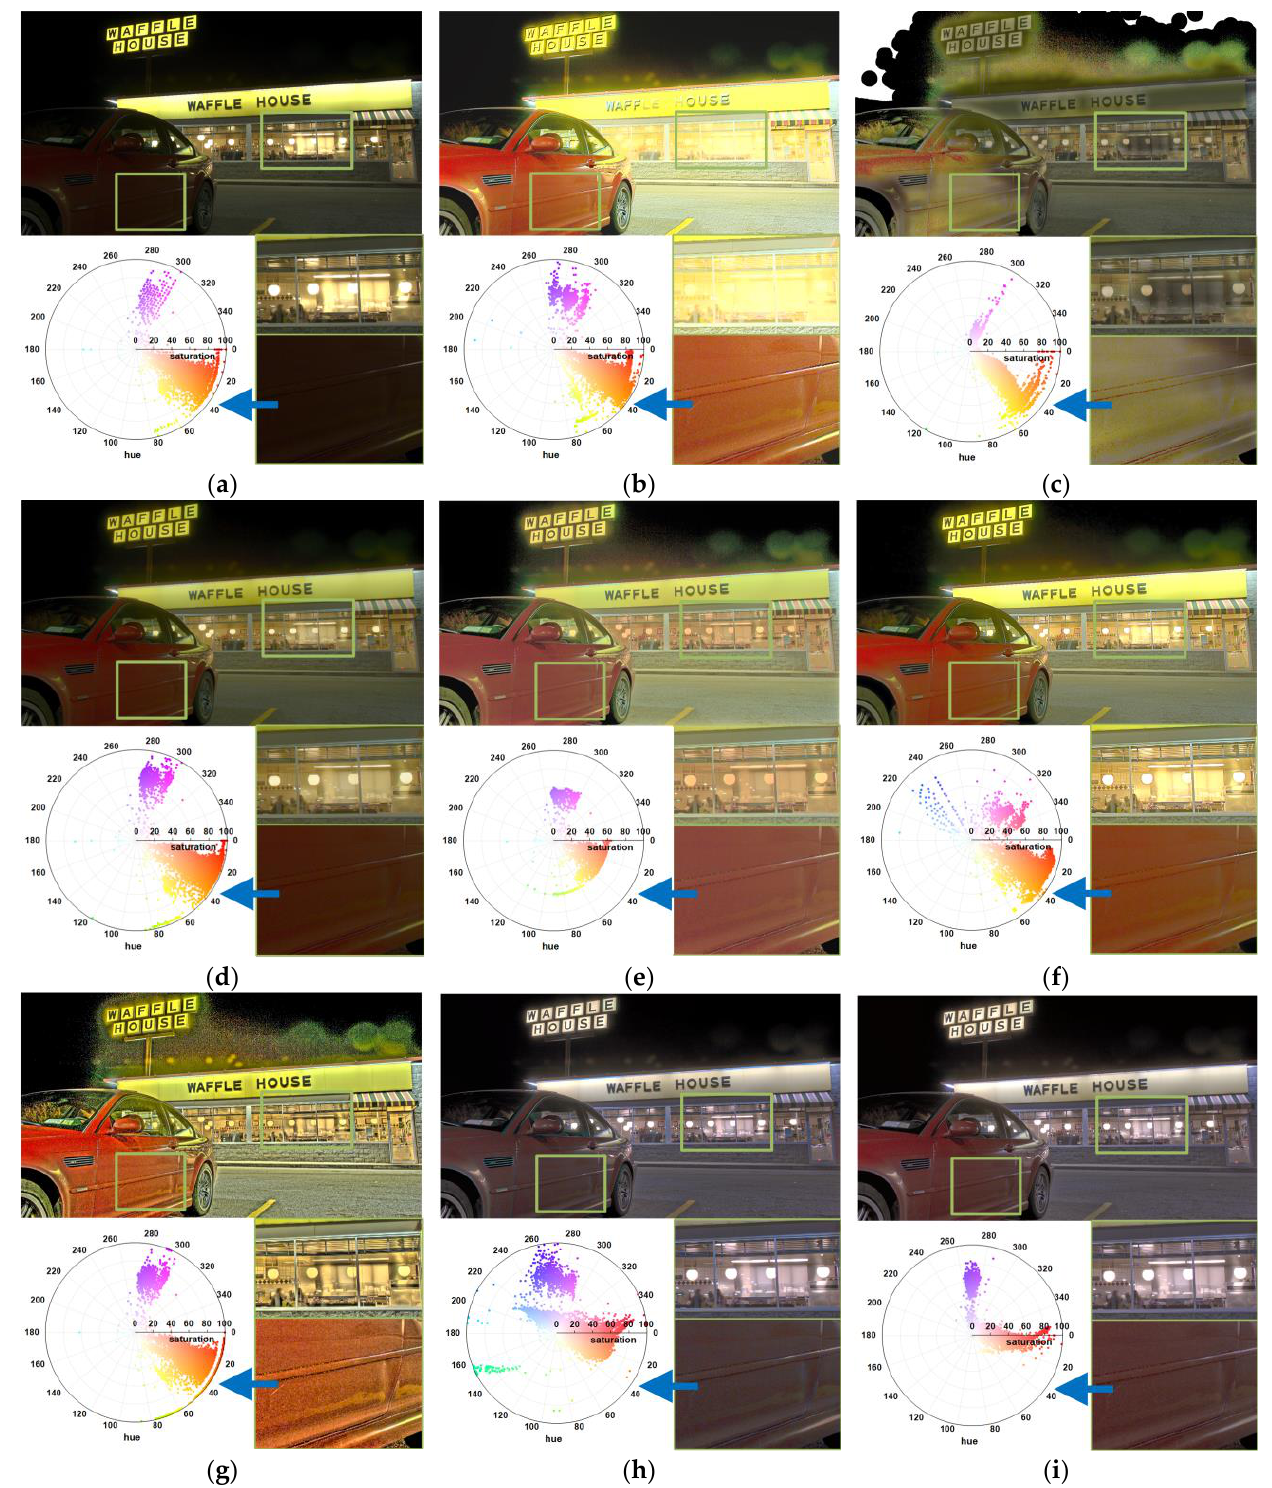
Figure 11. Rendering results of each method for HDR scene #4; ( a ) input image with Gamma tone mapping for visualization; ( b ) Banterle; ( c ) Bruce; ( d ) Reinhard; ( e ) Liang; ( f ) Li; ( g ) Shibata; ( h ) iCAM06; ( i ) proposed method.